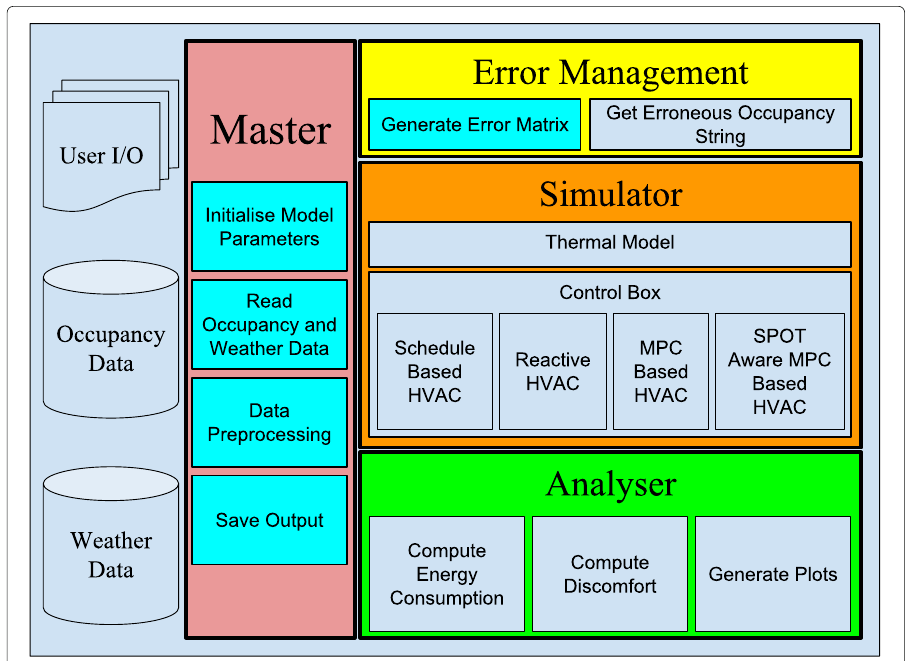
Fig. 1 Architecture. ThermalSim is a lightweight C/C++ based building simulation platform that focuses on analysing the influence of prediction errors on HVAC